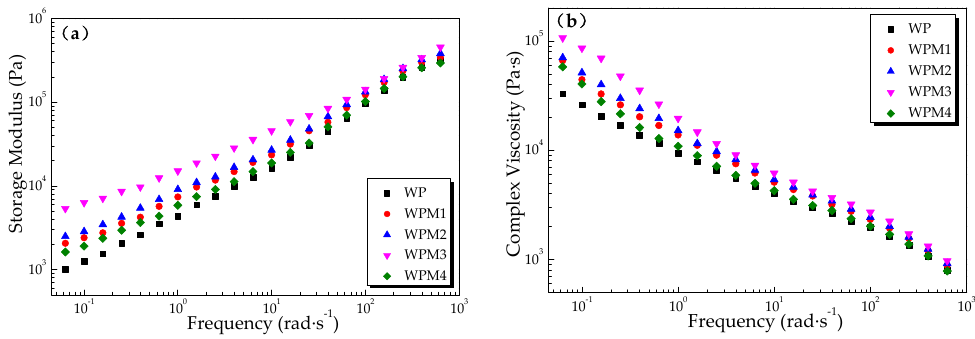
Figure 3. Dynamic rheological properties of the wood flour/PLA composites with different PLA- g -St/MAH loading rates: ( a ) storage modulus versus frequency and ( b ) complex viscosity versus frequency.